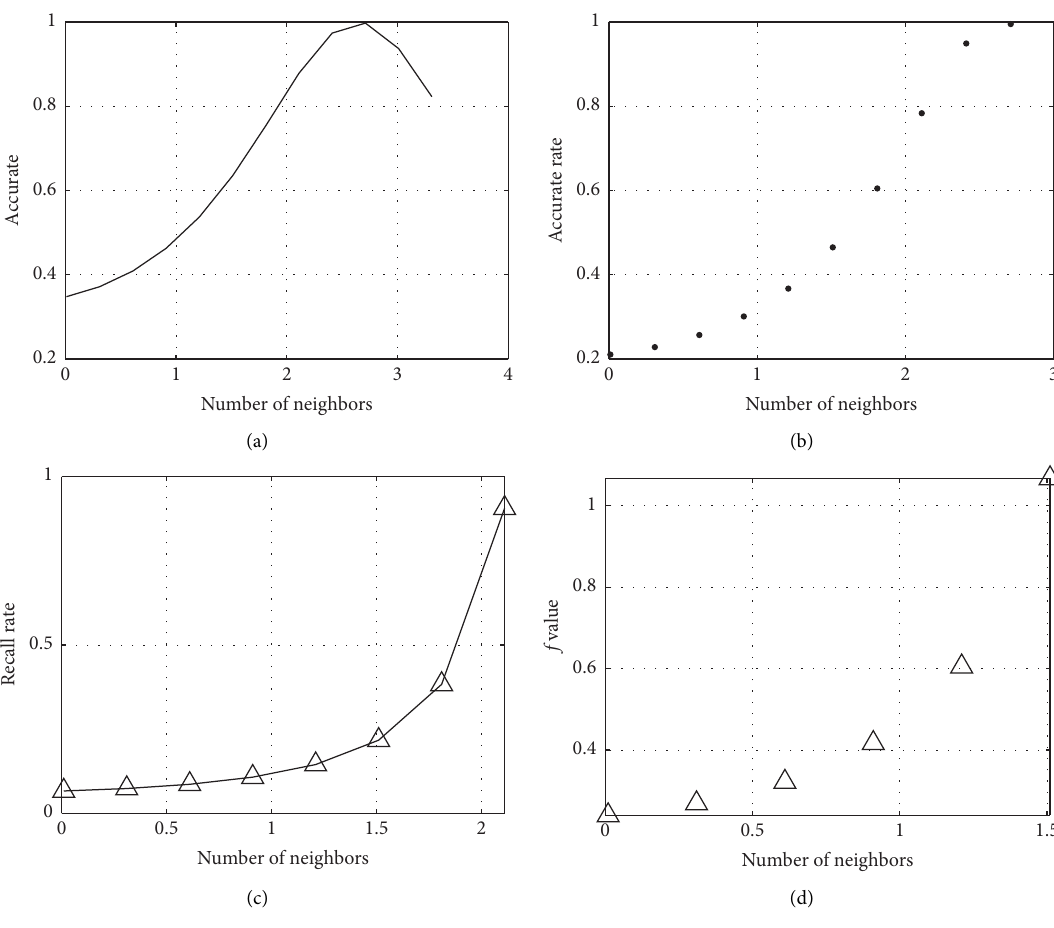
Figure 7: Partition-weighted K -nearest neighbor evaluation index curve. Table 5: Scores of each evaluation